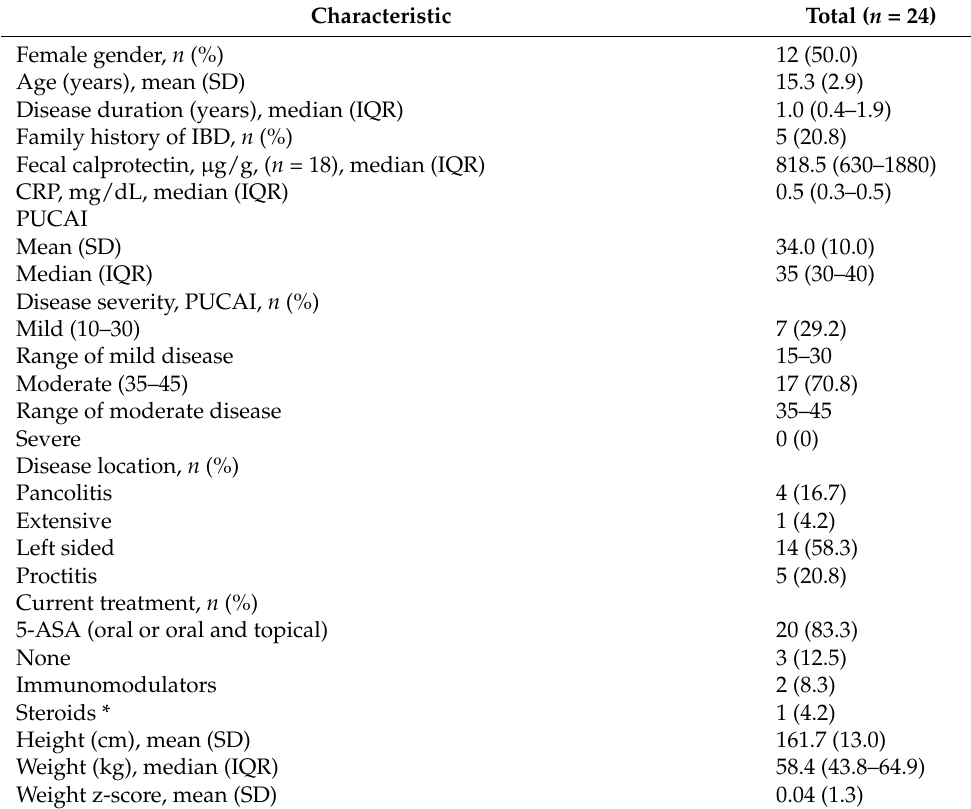
Table 1. Characteristics of the study patients at